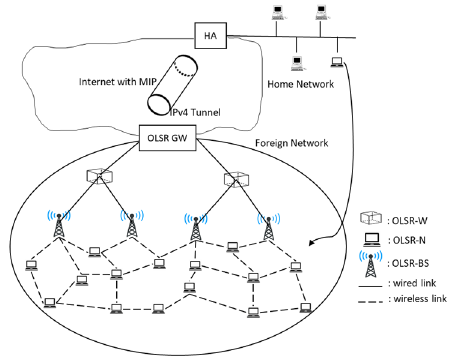
Figure 10. An OLSR-IP access network interconnected to a Mobile-IP [43].